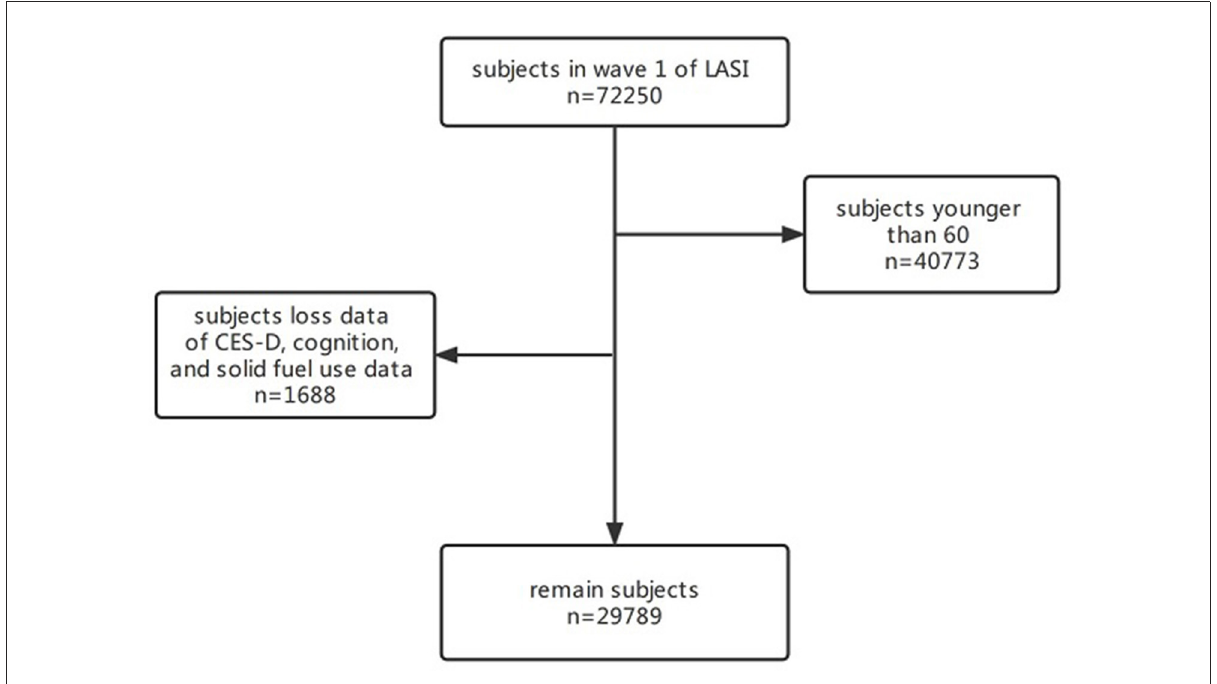
FIGURE1 Inclusion and exclusion of the study population.